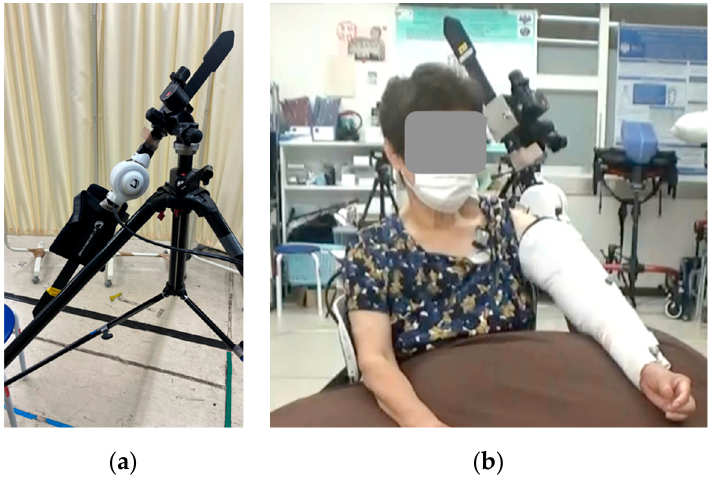
Figure 1. Images of the shoulder joint HAL device. ( a ) Single-joint HAL fixed to a tripod with attachments, ( b ) shoulder joint HAL fixed with splints and an elastic bandage. HAL, hybrid assistive limb.